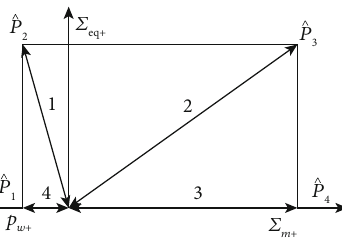
Figure 7: Critical cyclic loadings of the load domain considering the alternate wetting and drying condition.